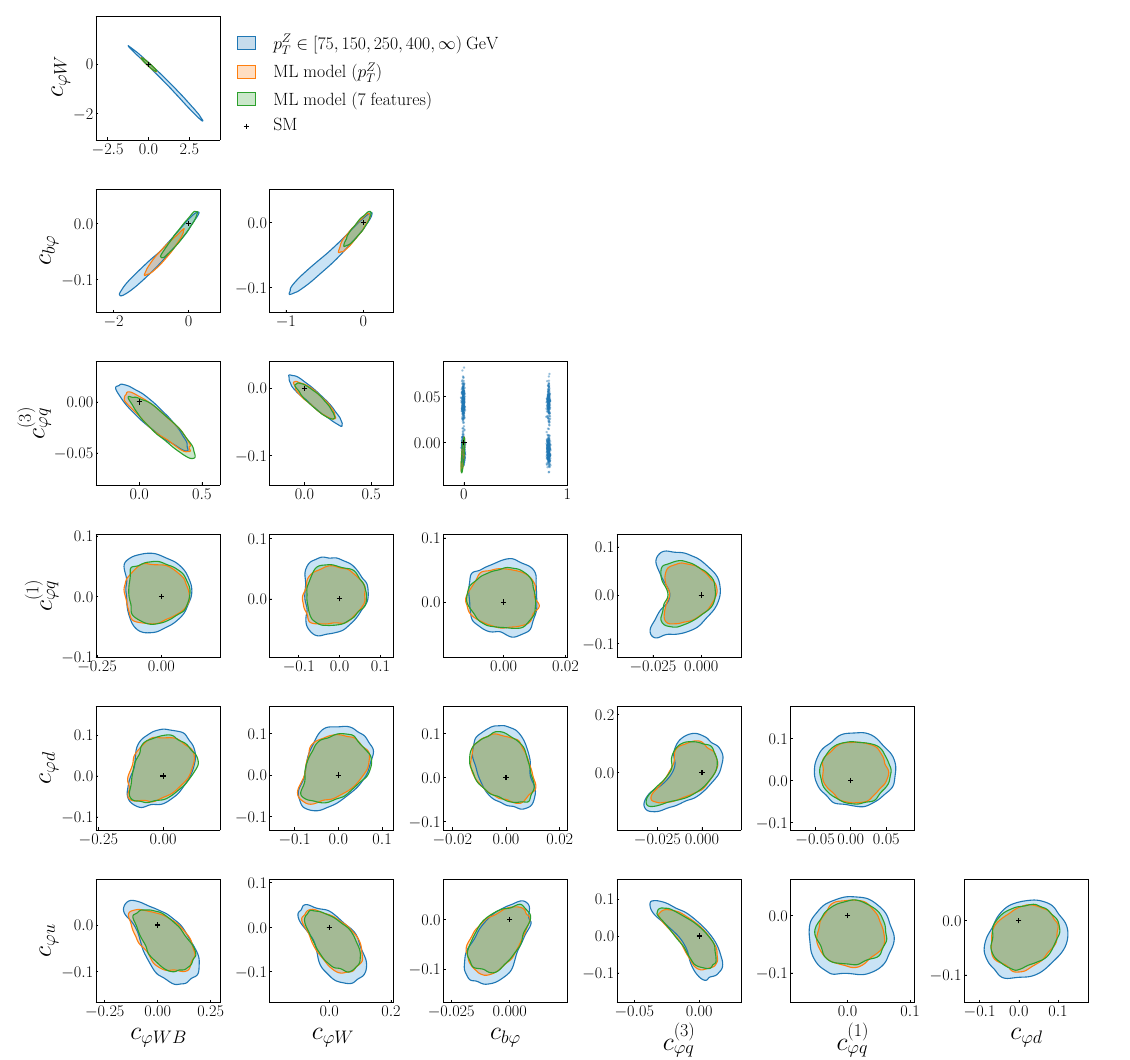
Figure 16. Same as figure 15 for the case in which the EFT calculations also include the quadratic O (Λ − 4 )